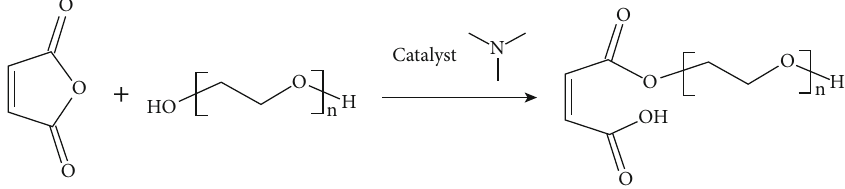
Figure 6: FTIR spectrum of PEG/MYNS MMM.